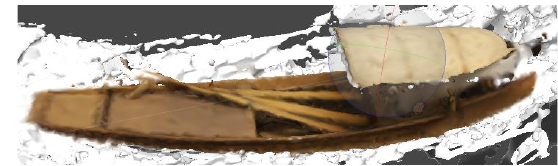
Figure 7a. Small Junk Model creating using DLSR Images and Agisoft MetaShape